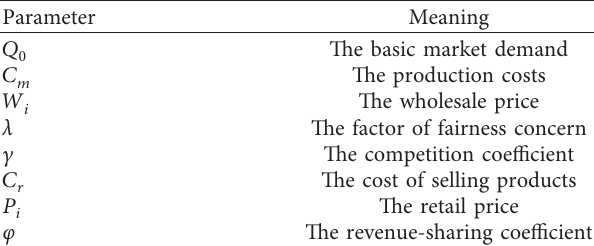
Table 1: Parameters and their